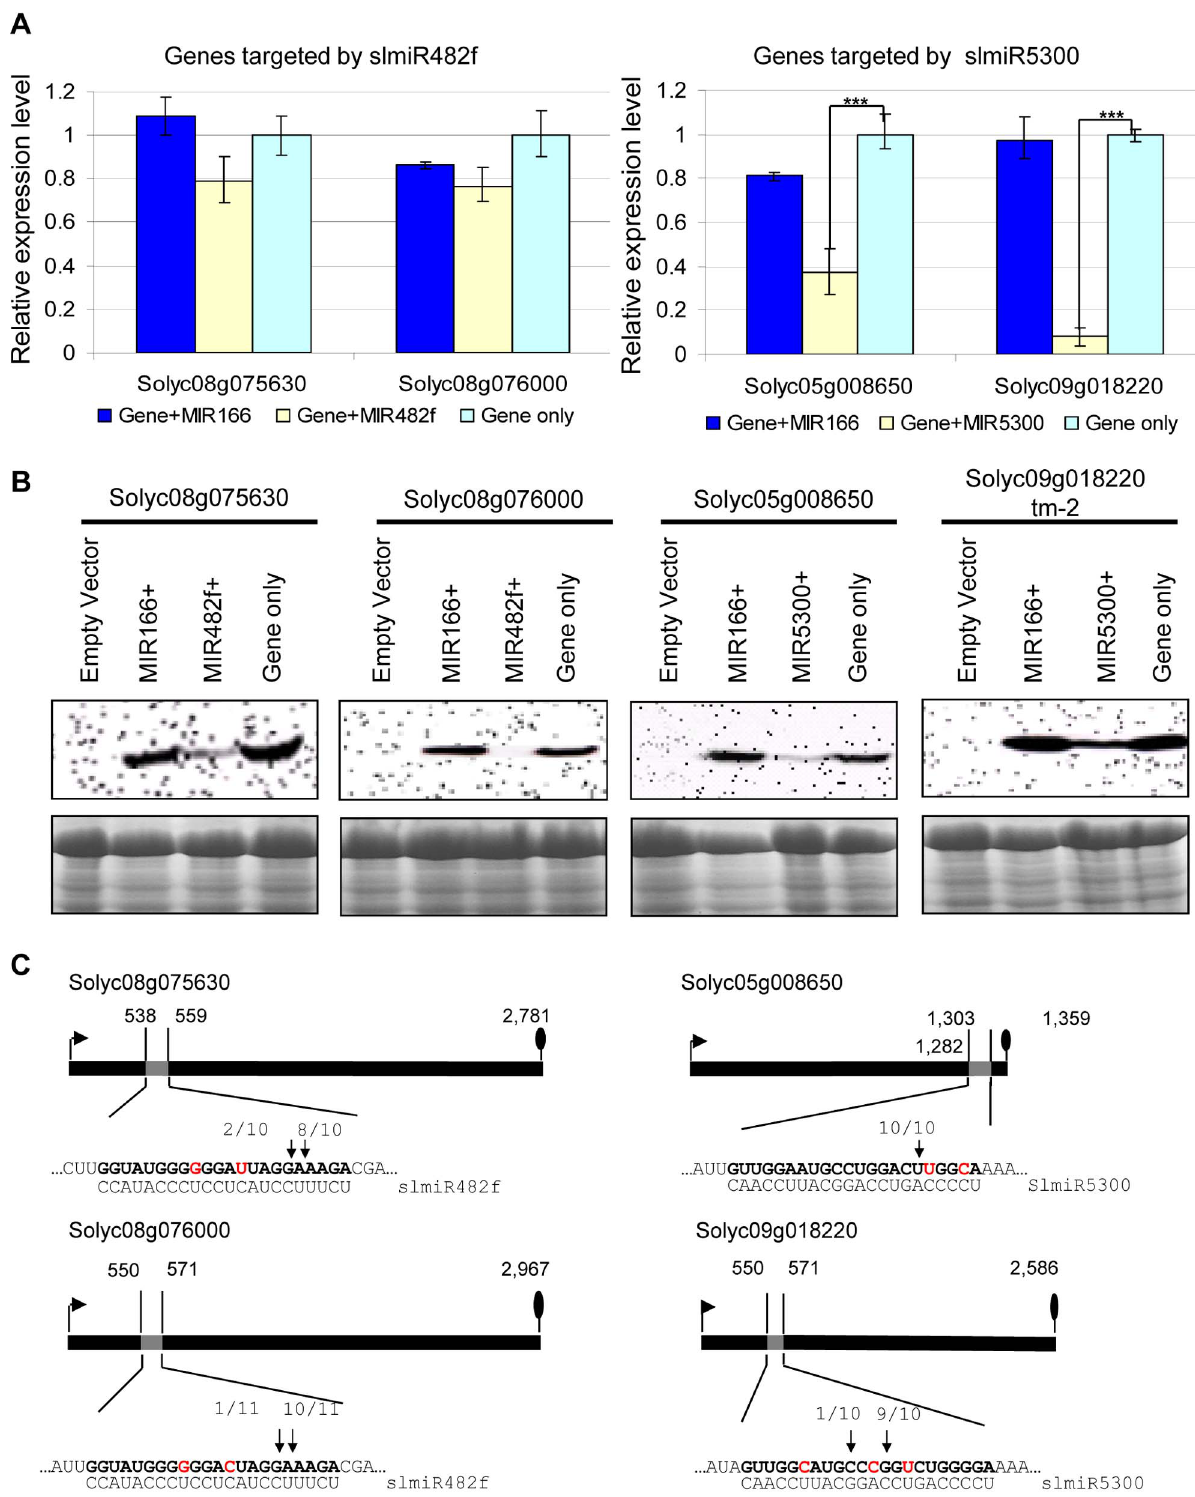
Figure 5. Co-expression of slmiRNAs and predicted targets in Nicotianabenthamiana leaves. A. Levels of target mRNAs. qRT-PCR was used to determine relative levels of predicted tomato mRNAs in N. benthamiana leaves expressing only empty vector; target mRNA and a control miRNA (slmiR166); target mRNA and the appropriate miRNA (slmiR482f or slmiR5300); or target mRNA and empty vector. Values were normalized to N. benthamiana actin. Errors are expressed as the standard error. *** indicates significant differences when compared to the corresponding control plants in the same treatments at p , 0.001. B. Target protein levels. Total protein isolated from the samples in (A) was electrophoresed on SDS- PAGE gels and blotted onto nitrocellulose membranes. A FLAG antiserum was used to detect the tagged target proteins during western analysis as described in the Materials and Methods (top panels). A duplicate gel was Coomassie-stained and used as a loading control (bottom panels). Similar